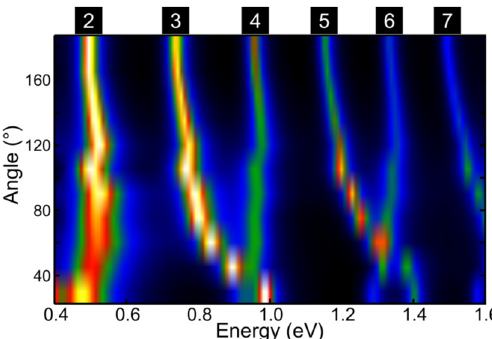
Figure 2: Simulated EEL spectra as a function of bending angle of the 15.5 aspect ratio silver NWs. The spectra show the energy shifts on the resonant modes that, at low bending angles, cause even and odd modes to intersect in